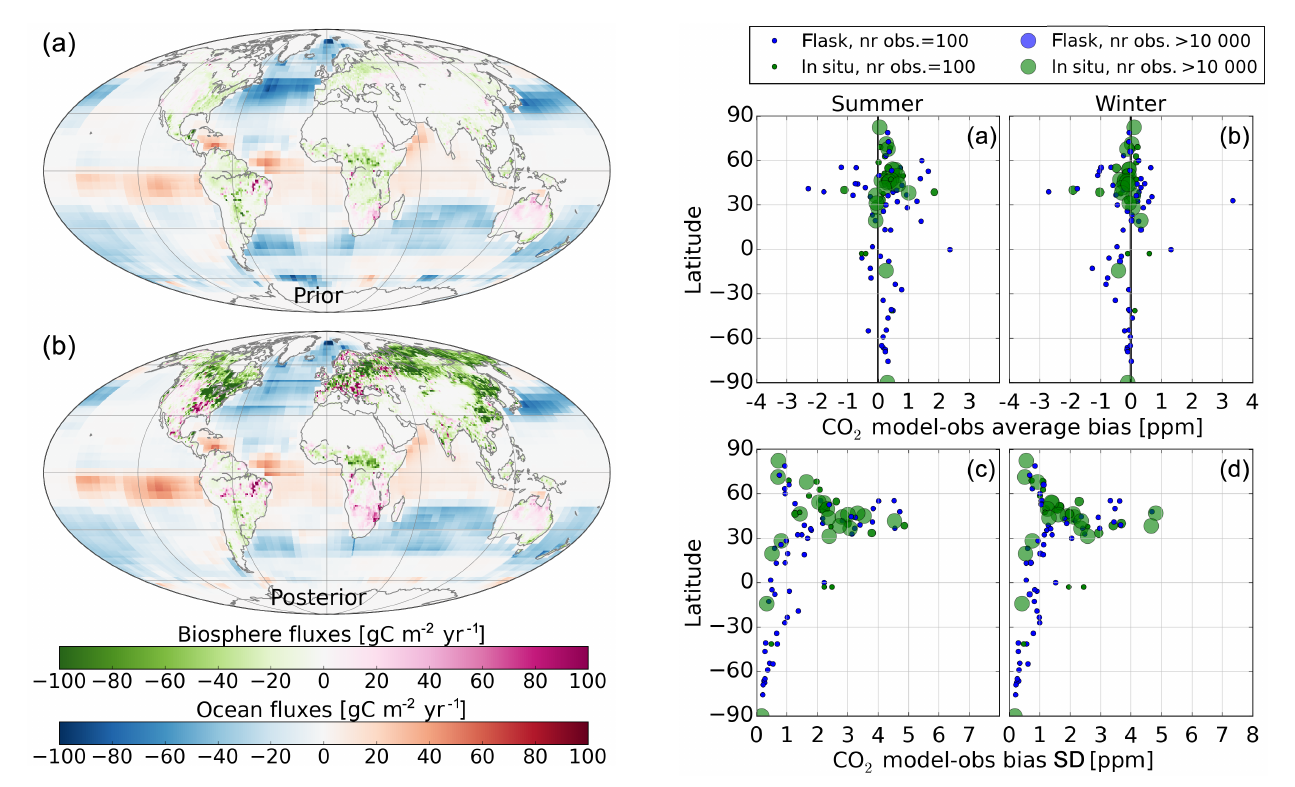
Figure 6. Latitudinal distribution of the average posterior residuals (a, b) and their SDs (c, d) per site over the period 2001–2015, for Northern Hemisphere summer (a, c) and winter (b, d) . The residu- als are calculated as the difference of the simulated minus observed CO 2 mole fractions for all assimilated observations. Assimilated values do not include CO 2 mole fractions of which their observed forecasted value exceeds 3 times the prescribed model–data mis-